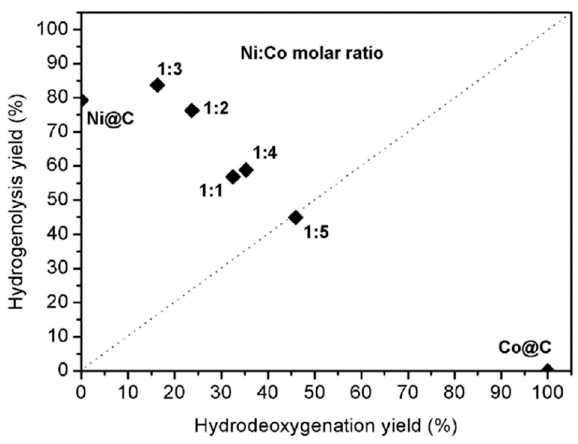
Figure 19. The correlation between the reaction selectivity and the composition of bimetallic nanoparticles for Ni@C, Co@C, and Ni-Co@C [119] .